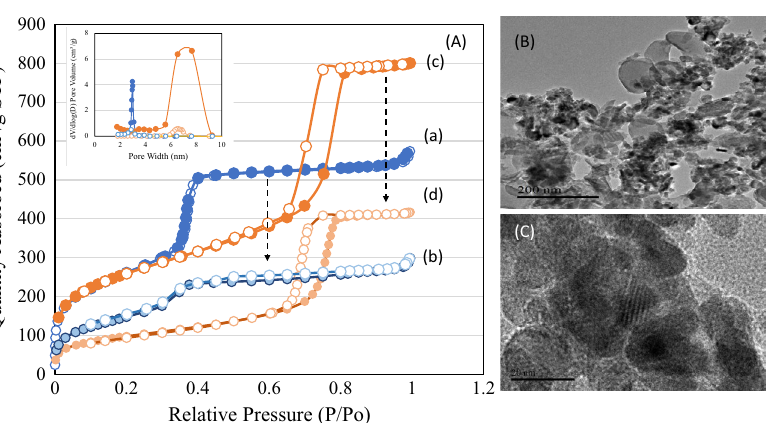
Figure 2. ( A ) Nitrogen adsorption isotherm pattern of (a) MCM-41, (b) MCM-41/ZIF-8, (c) KIT-6 and (d) KIT-6/ZIF-8. ( B , C ) Shows the transmission electron microscope images of KIT-6/ZIF-8 at magnification of 200 nm and 20 nm,